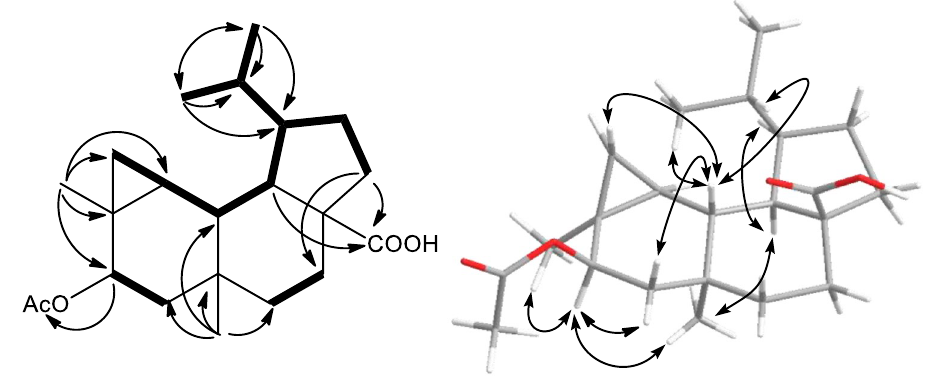
Fig. 2 1 H– 1 H COSY, key HMBC and NOE correlations of